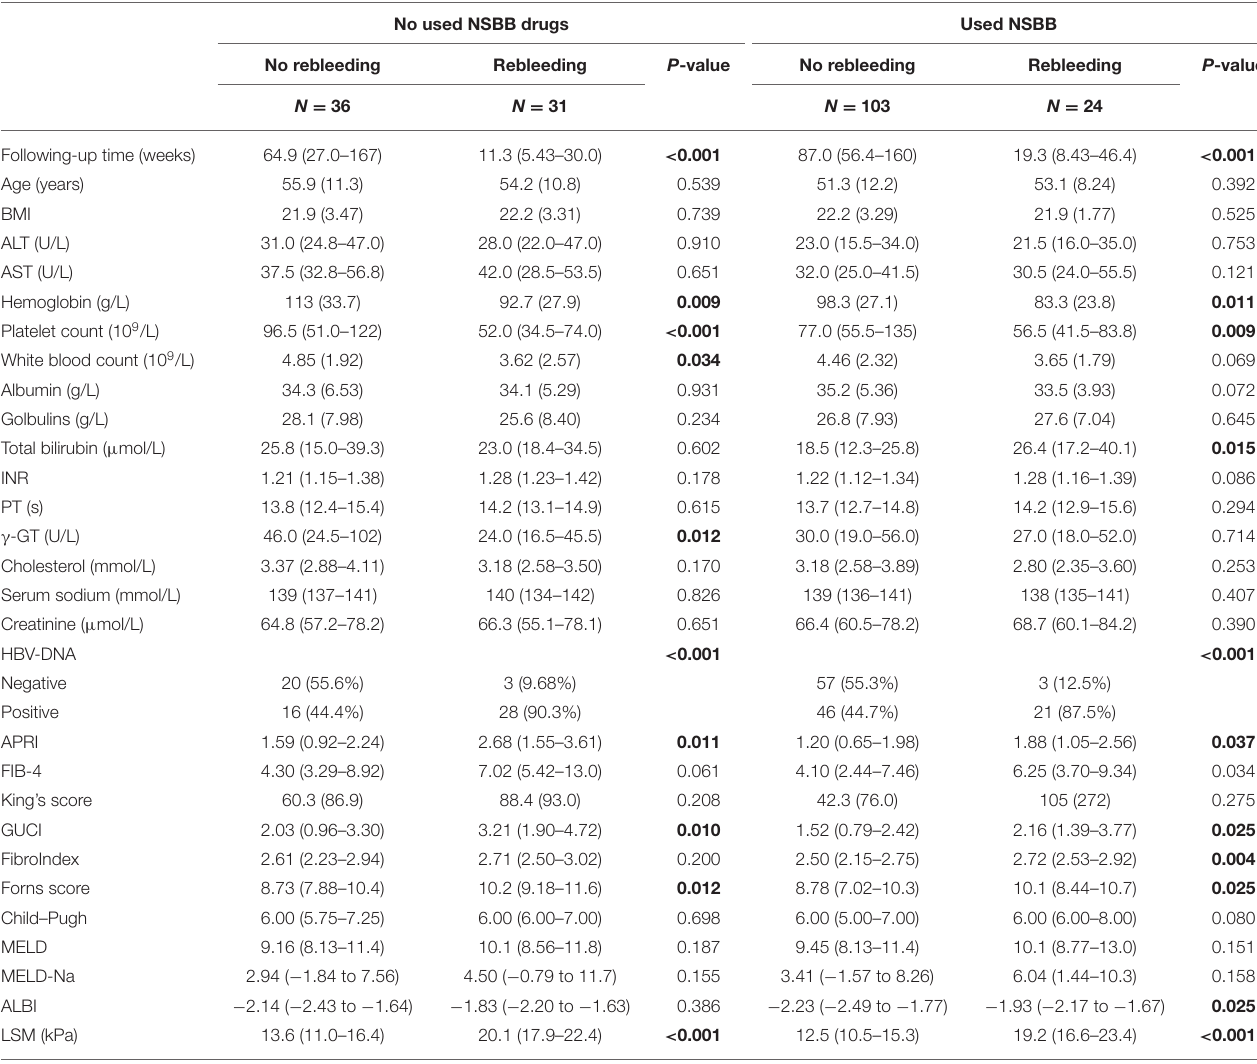
TABLE 3 | Baseline comparison of patients with and without NSBB